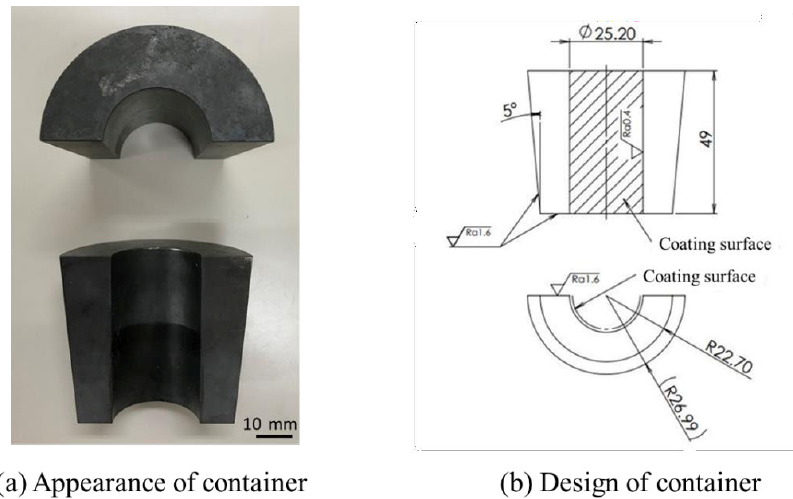
Fig. 7 Segmented container for forward–backward extrusion